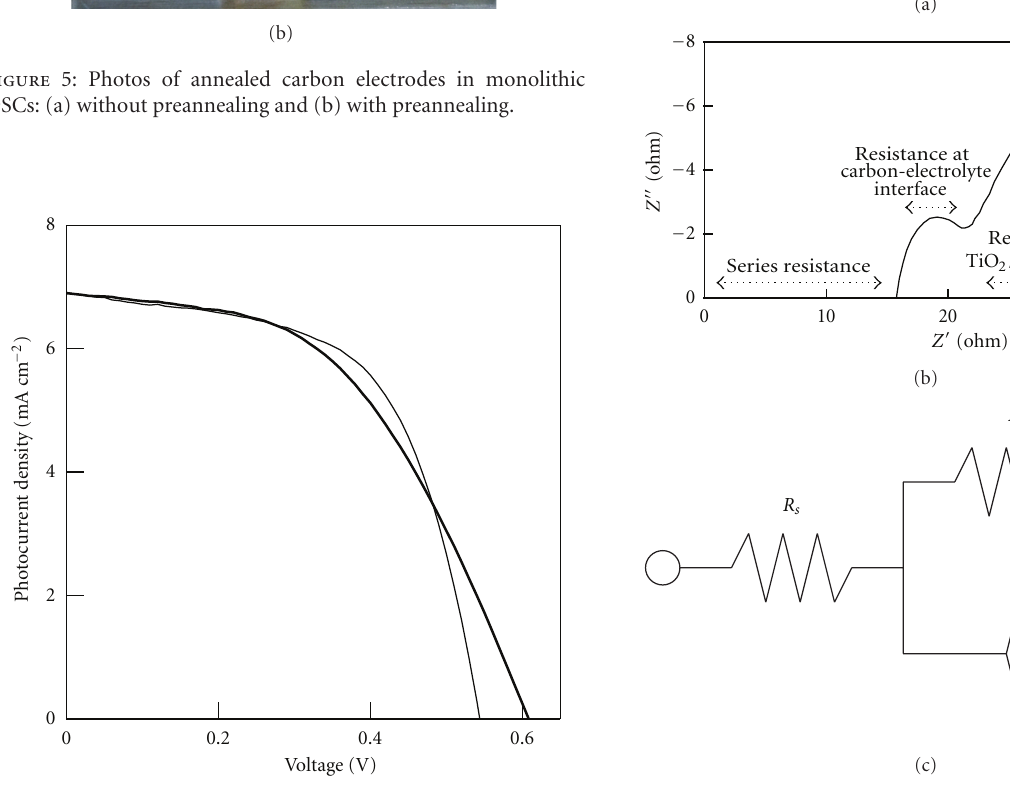
Figure 7: Impedance spectra (Cole-Cole plot) of monolithic- (a) and sandwich- (b) structured DSCs, which was analyzed using an equivalent circuit (c), where R s , R p , and CPE are series resistance, parallel resistance and constant-phase element (imperfect capaci- tance),